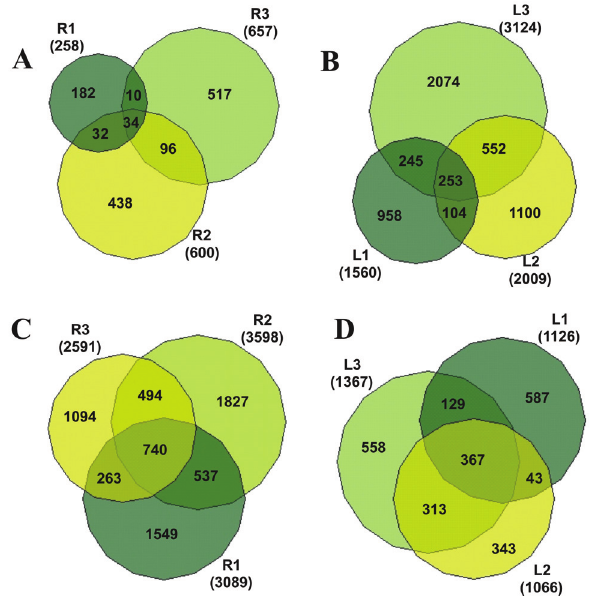
Figure 4 - Venn-Master diagram. Libraries were compared to each other to show the number of genes expressed only in one library and the ones common to different libraries. R(L)1, R(L)2 and R(L)3 represent genes expressed in 25-50, 75-100 and 125-150 min under stress. (A) BR 16